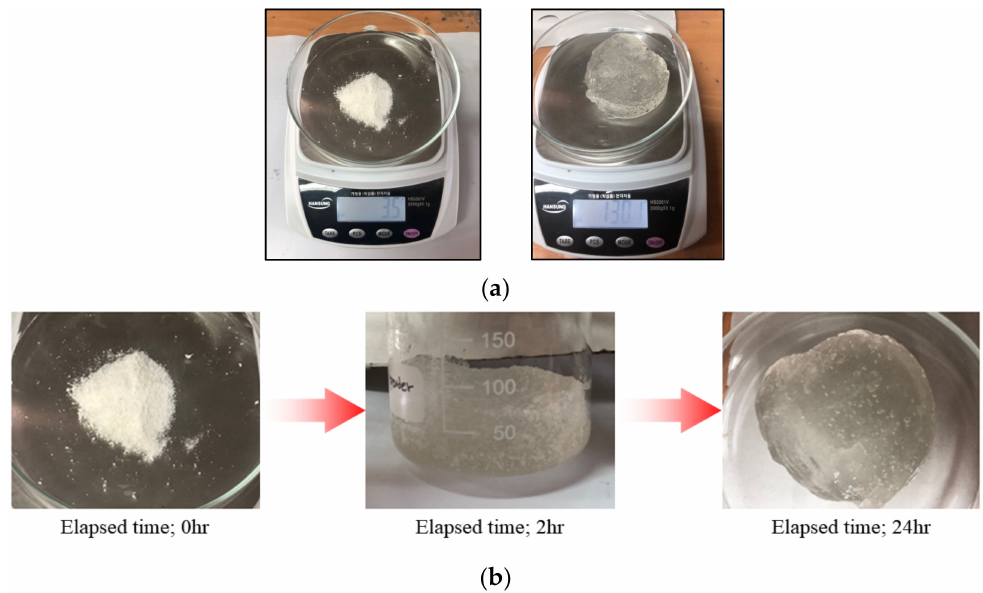
Figure 2. Absorption, expansion, and gelation of polynorbornene (reactive material): ( a ) Weight change after the reaction with TPH, before: 3.5 g, after: 130.1 g; ( b ) Gelation over time